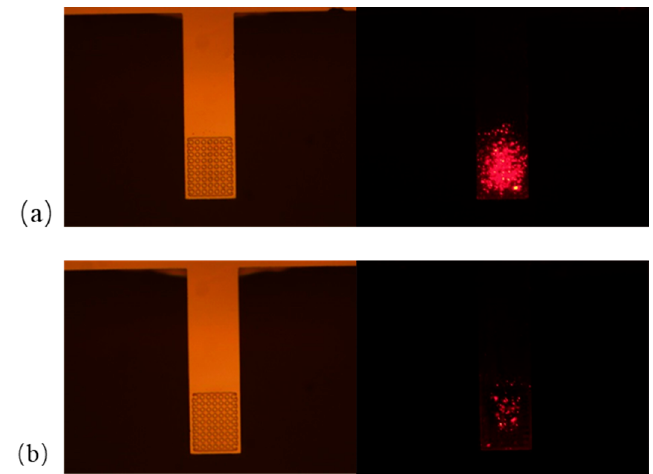
Figure 6. Fluorescence microscope observation results ( a ) with and ( b ) without modifying the secondary antibody to the surface of the cantilever prior to incubating the F1 antibody.